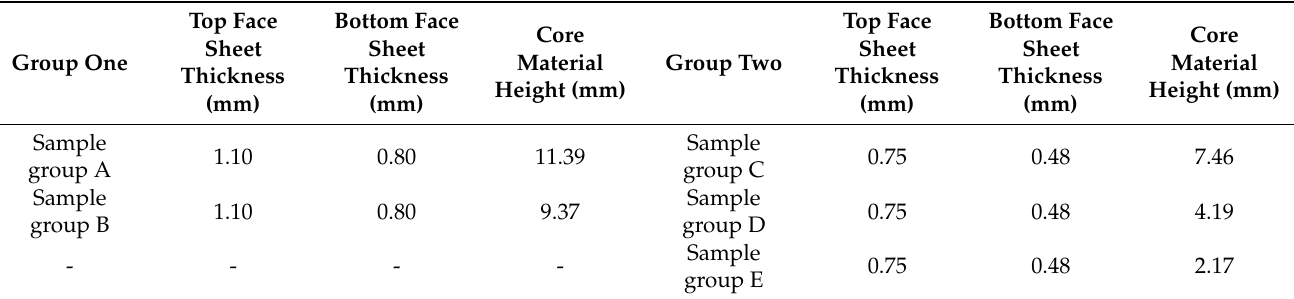
Figure 5. Picture of flat compression specimens. Table 3. Two sets of samples for comparison.